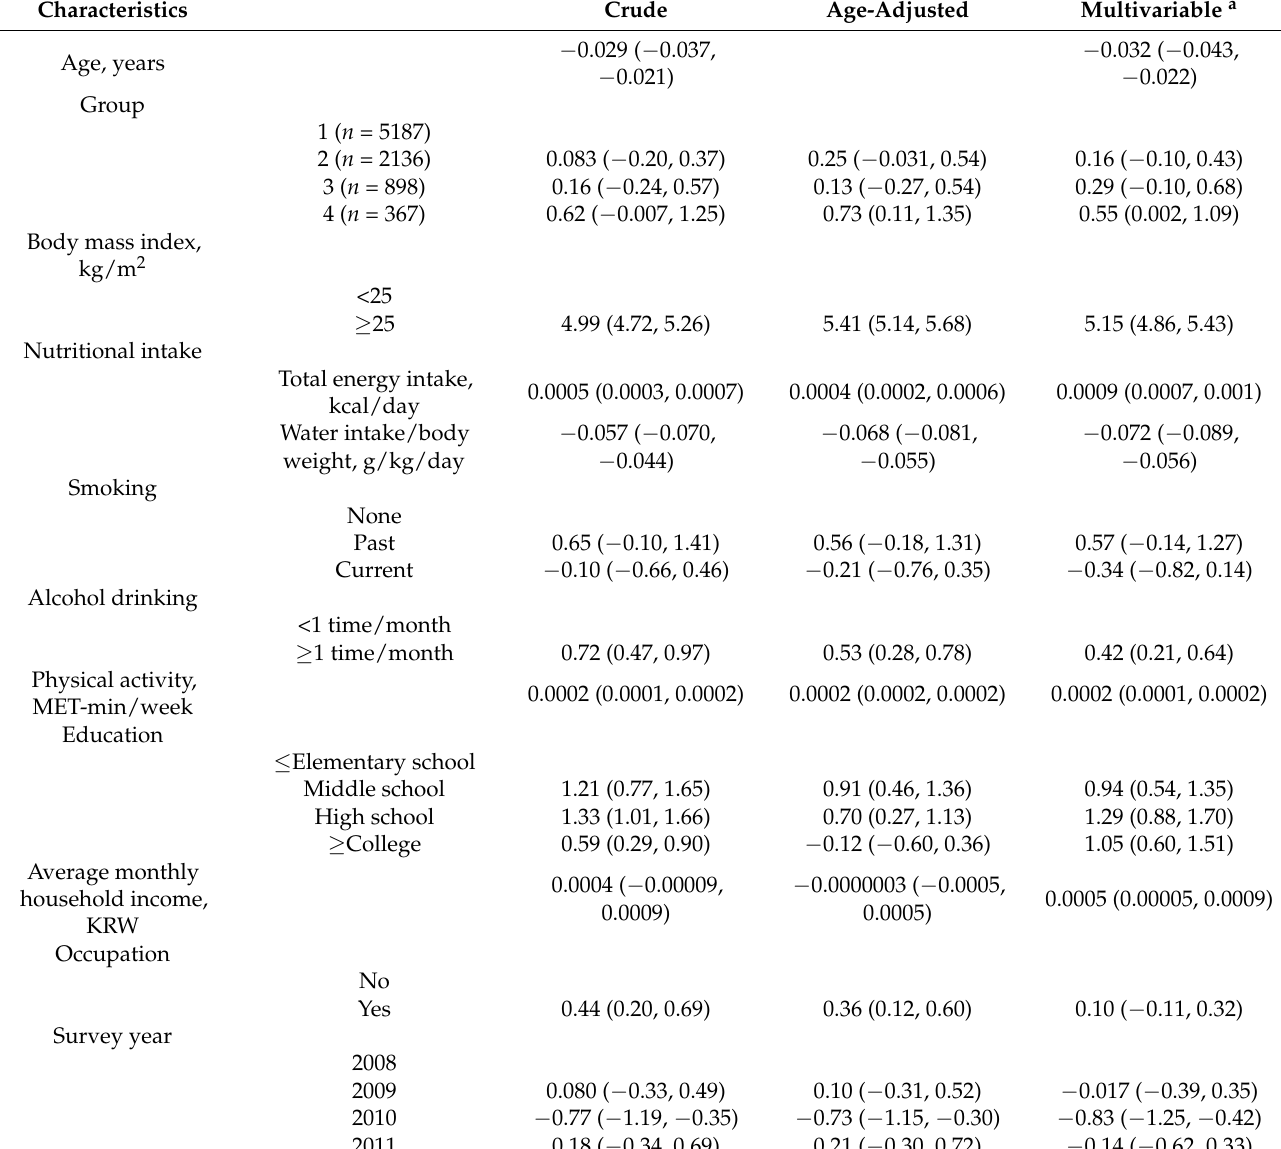
Table 5. Linear regression analysis of changes in whole body total fat-free mass by group in women.